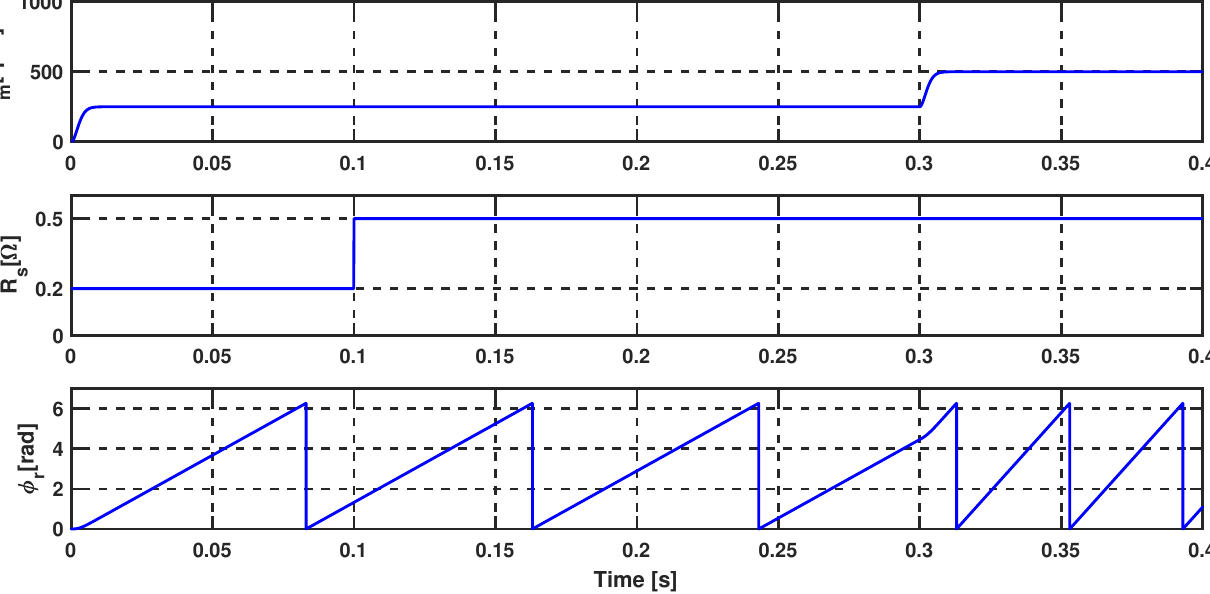
Figure 13. Simulation results of multiple vector 3VV FCS-MPC at step change in the PMSM resistance R s (from top): Speed ω m , resistance R s , and rotor angle φ r